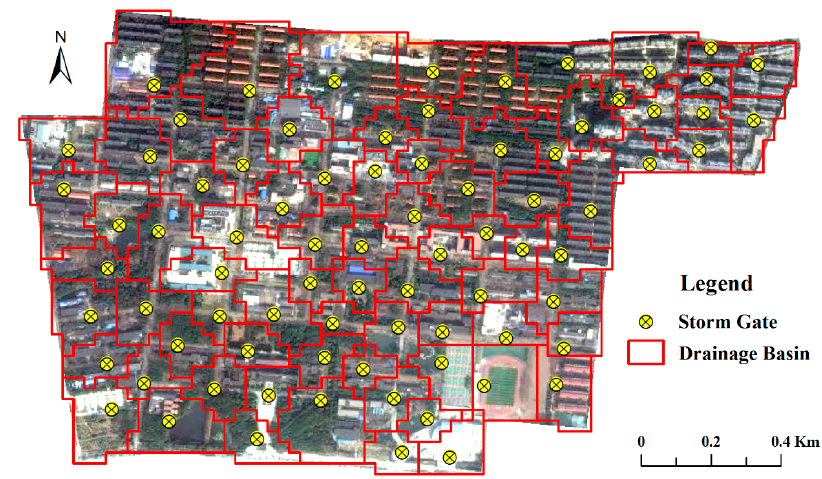
Figure 8. Spatial distributions of drainage basins and storm gates in the study area.